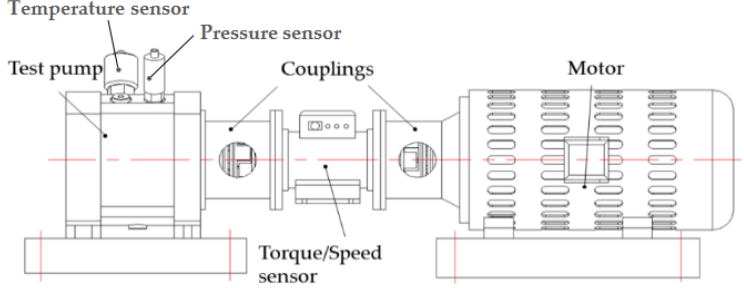
Figure 2. Test rig of churning losses.